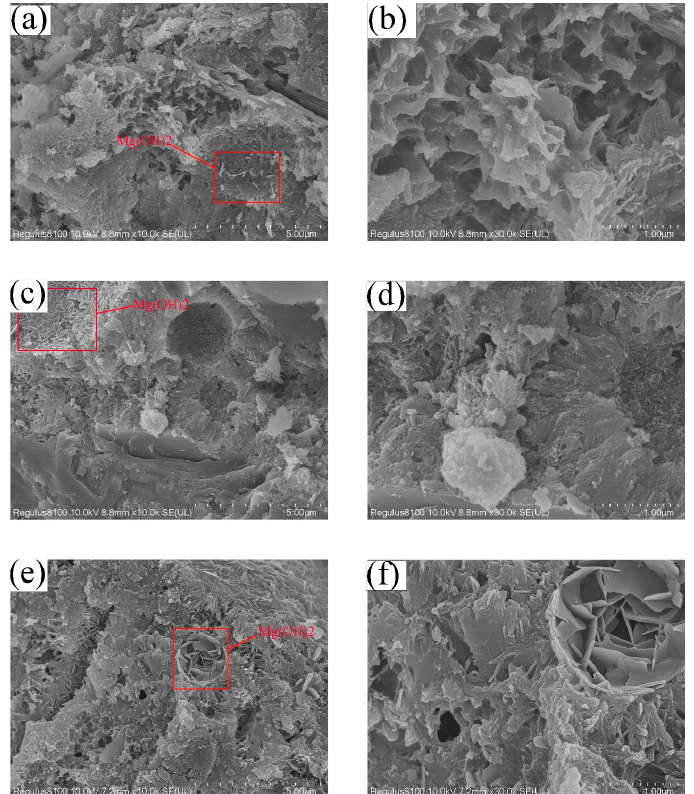
Figure 10. SEM images of hydration product in cement containing 8% MEA at 7 days ( a ) Microscopic morphology under temperature condition A; ( b ) Pore structure under temperature condition A; ( c ) Microscopic morphology under temperature condition B; ( d ) Microscopic morphology of Mg(OH) 2 under temperature condition B; ( e ) Microscopic morphology under temperature condition C; ( f ) Microscopic morphology of Mg(OH) 2 under temperature condition